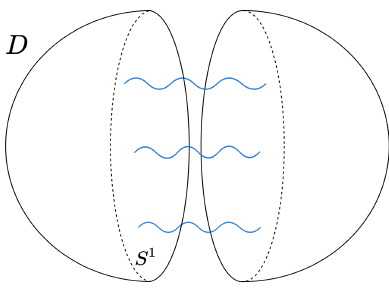
Figure 2 . The T = 0 slice of global de Sitter split into two static patch hemispheres at the S 1 horizon. These hemispheres are topologically disks, and we can imagine ‘tracing out’ the degrees of freedom in one of the static patches that is behind the horizon of the